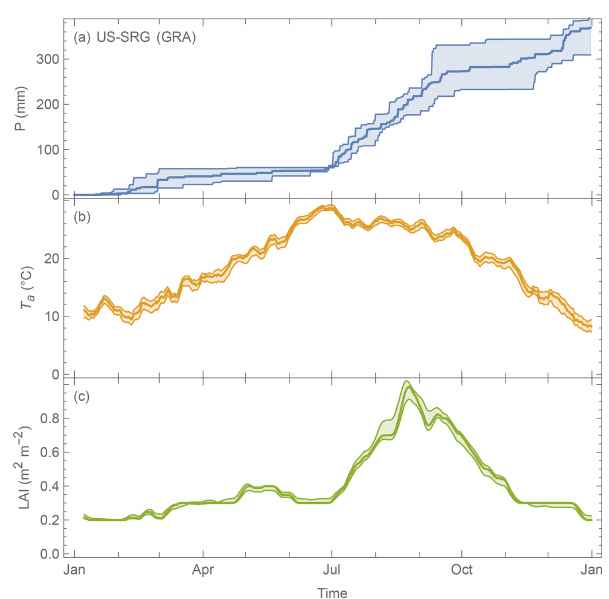
Figure D2. As Fig. D1, but for US-SRG (GRA according to IGBP; time span: 2008–2015;